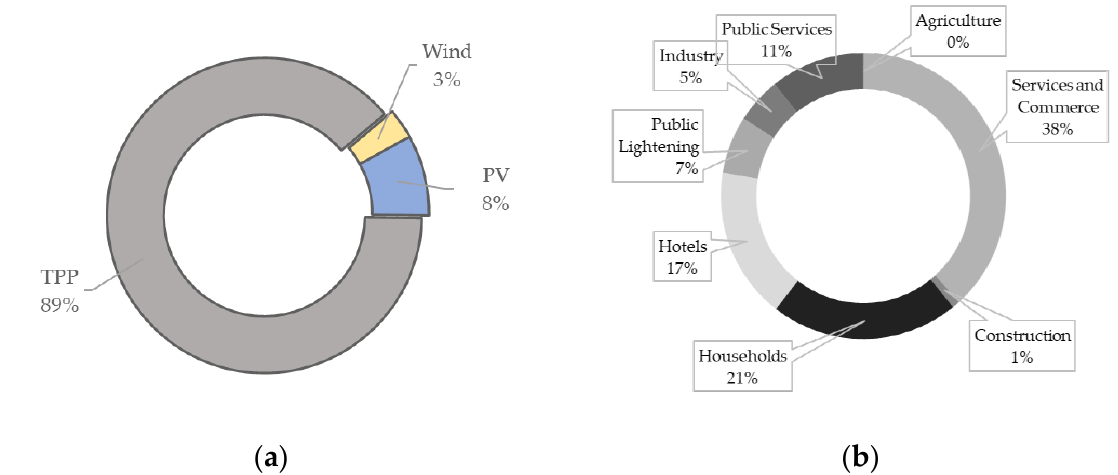
Figure 2. Energy supply and demand for 2015, adapted from the annual report published by the EEM [48]. ( a ) Electricity generation by share of each resource in percentage. ( b ) Consumption by activity.